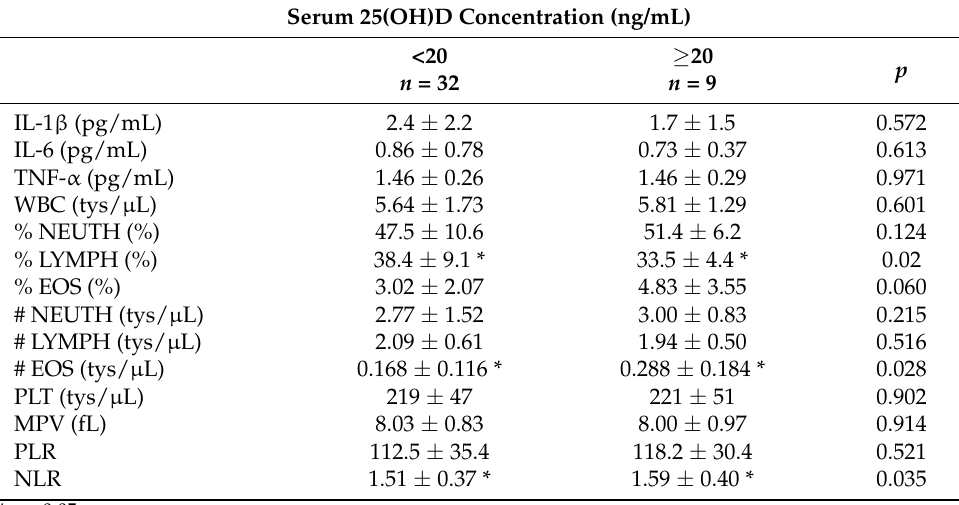
Table 3. Cytokine levels and hemogram parameters (mean ± SD) relative to 25(OH)D levels.